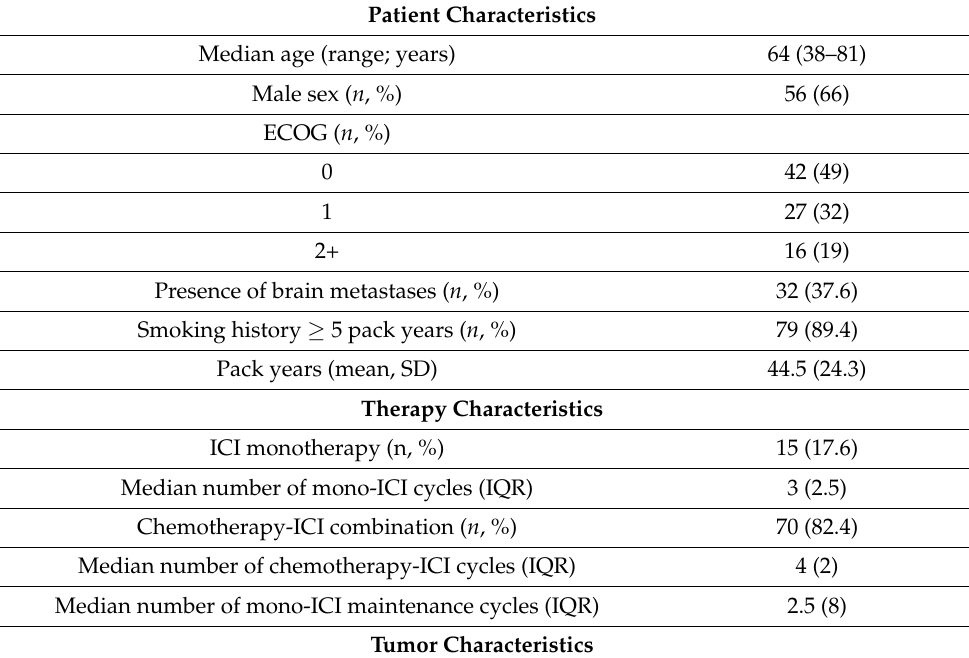
Figure 1. Patient disposition. NSCLC = non-small cell lung cancer, PET/CT = positron-emission tomography/computed tomography, ICI = immune checkpoint inhibitor. Table 1. Baseline characteristics. ECOG = Eastern Cooperative Oncology Group, SD = standard deviation, ICI = Immune checkpoint inhibitor, IQR = interquartile range, NSCLC = non-small cell lung cancer, PD-L1 = programmed death-ligand 1, PET/CT = positron-emission tomography/computed tomography, SUV = standardized uptake value.